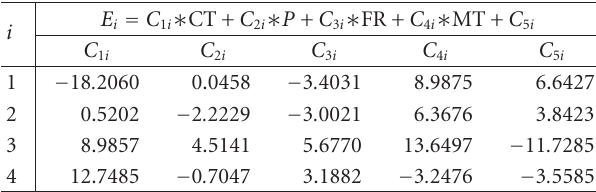
Table 6: The weights between input layer and hidden layer for 316L.